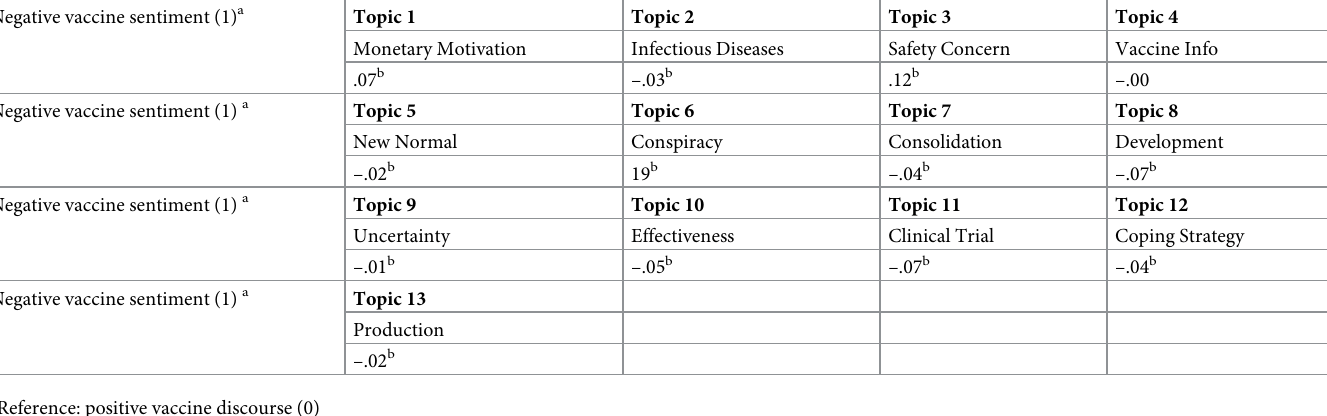
Table 2. Regression analysis predicting topical prevalence by positive and negative vaccine